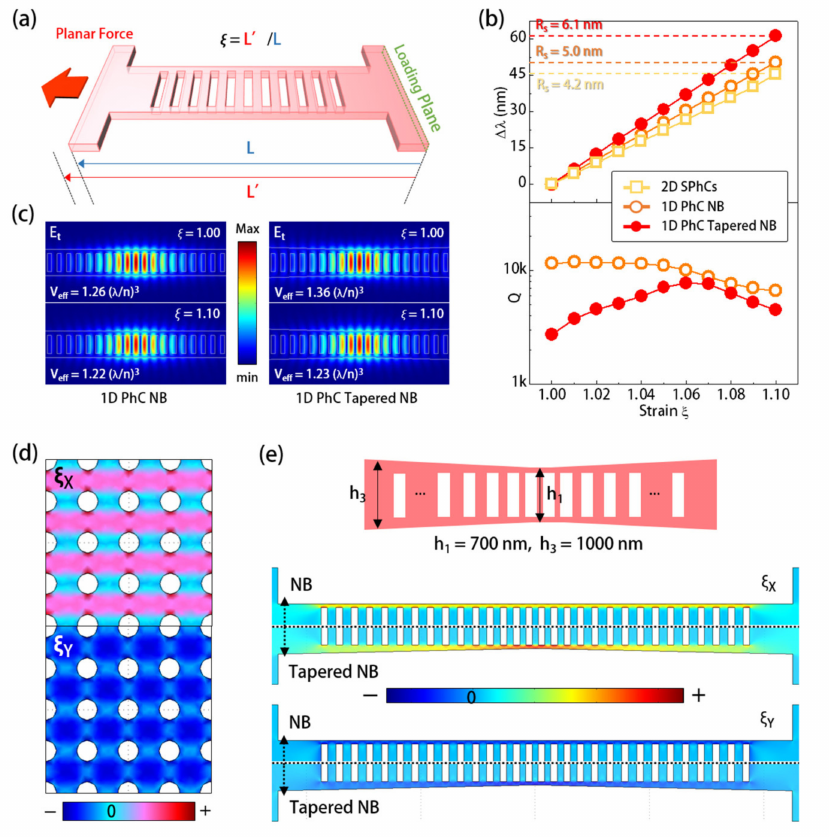
Figure 5. ( a ) Schematics of stretching sample in FEM simulation and definition of stretching